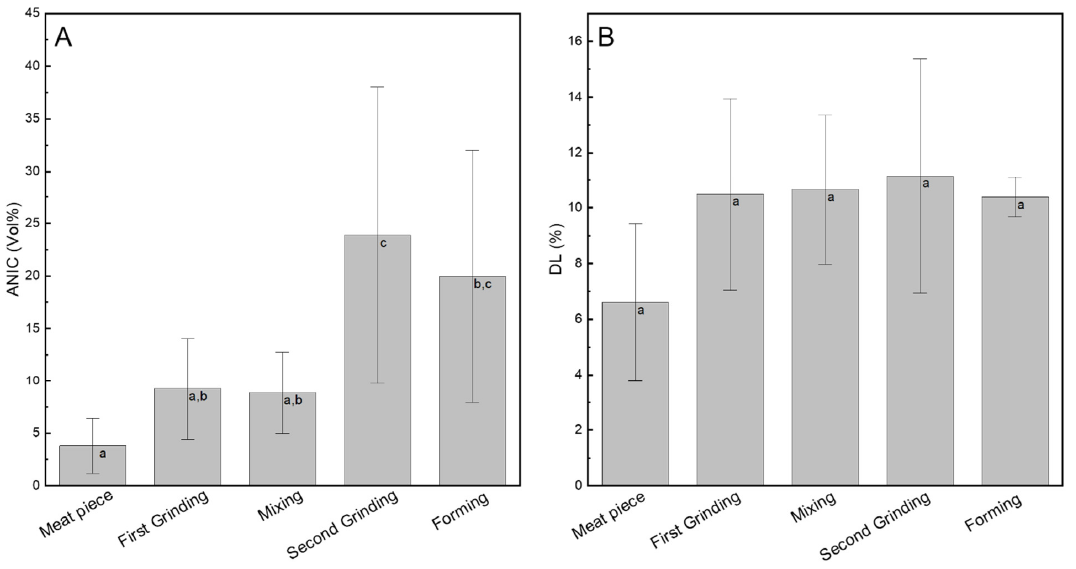
Figure 2. Characterization of the structural and functional parameters: ( A ) amount of non-intact muscle fibers ( ANIC ) and ( B ) drip loss ( DL ) of the meat samples at different processing stages. Data points with different letters are significantly different ( p < 0.05), n = 3.